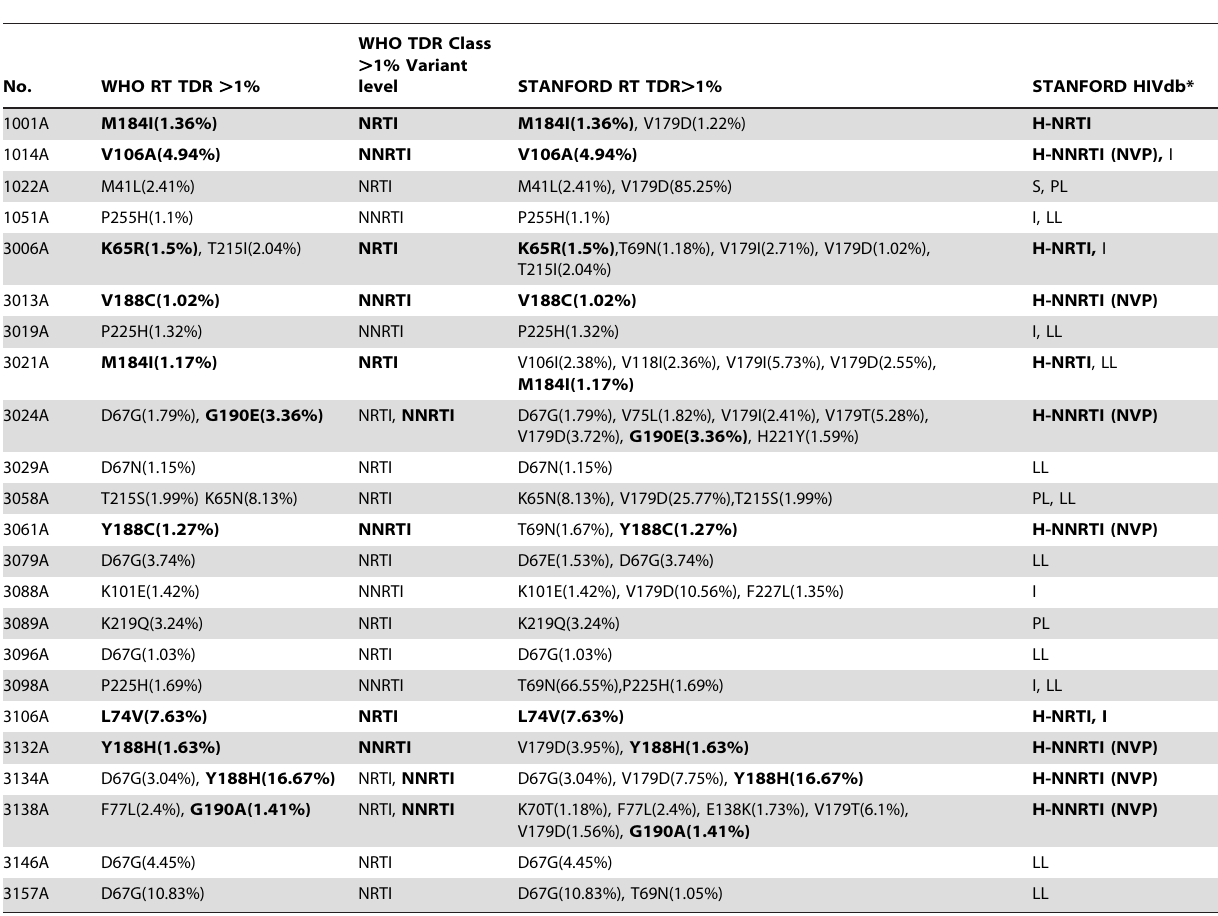
Table 3. HIV drug resistance reverse transcriptase (RT) mutation detection by deep sequencing (DS).